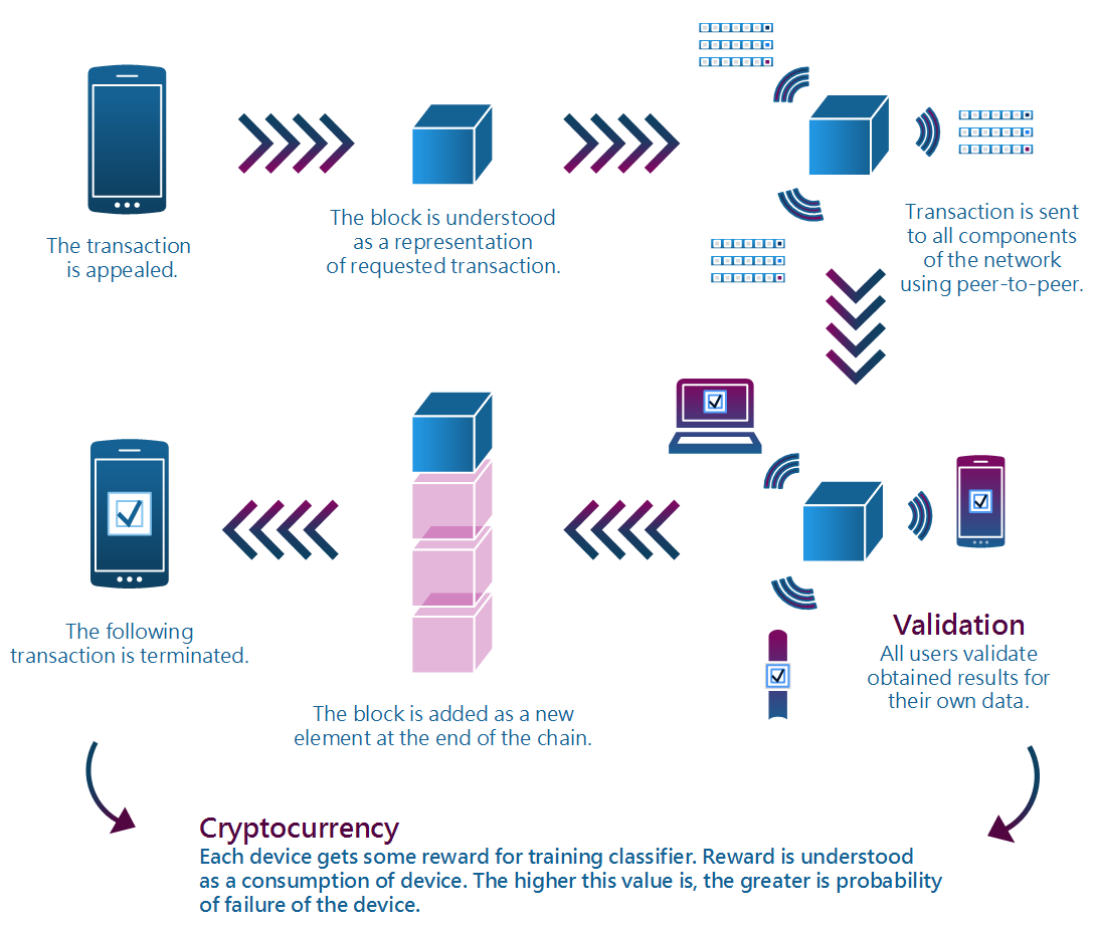
Figure 1. Visualization of the proposed blockchain–inspired technique for the operation of artificial intelligence on local